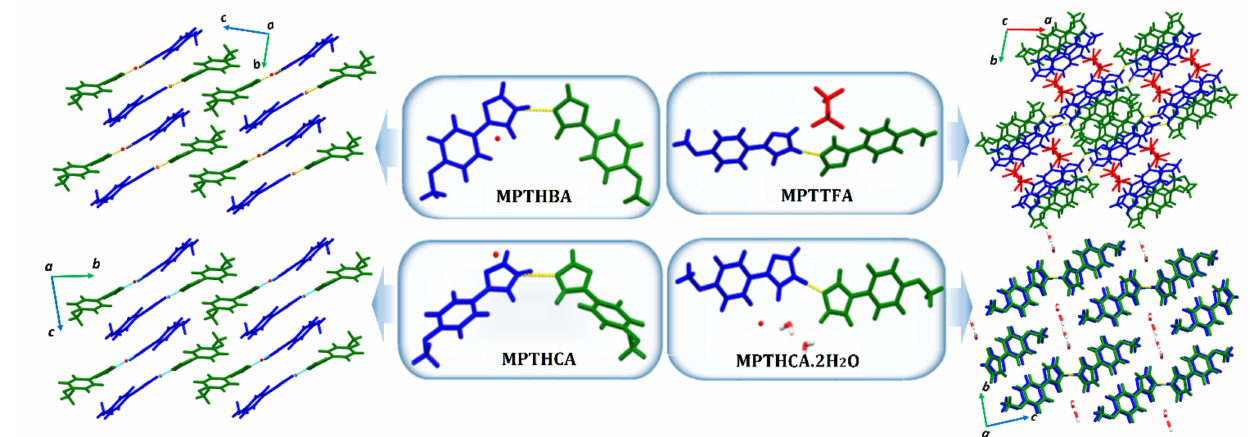
Figure 5. Local structure and crystal packing of ICCs containing MPT.